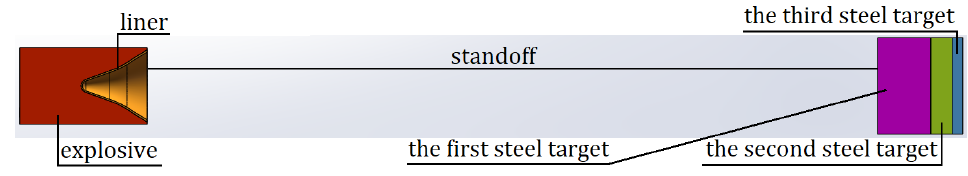
Figure 3. Penetration model without the simulation cabin.